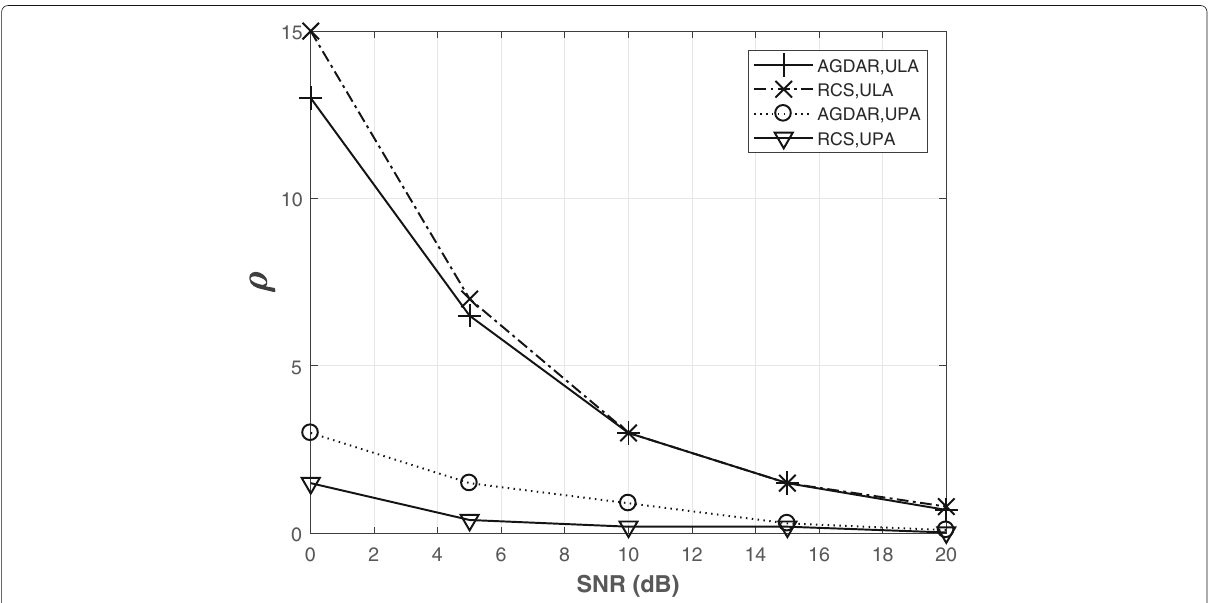
Fig. 2 Choice of ρ . Optimized value of ρ vs SNR , for both UPA, with N r = 16 = 4 × 4 ( D 0 = D 1 = 4) and N t = 4 = 2 × 2 ( D 2 = D 3 = 2) and M 0 = M 1 = M 2 = M 3 = 8, and ULAs with N r = 16, N t = 4 and M 1 = M 2 = 32. UMi LOS model